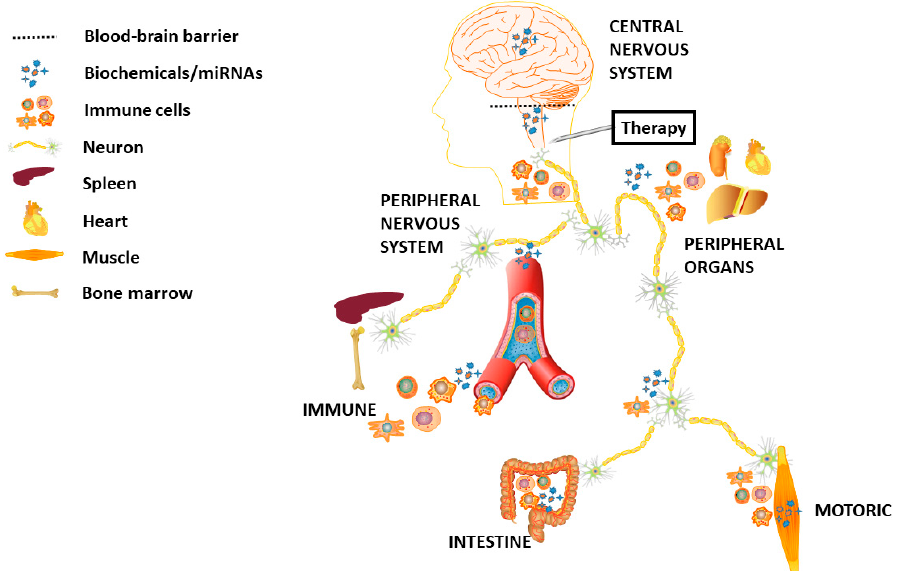
Figure 1. Conceptual visualization of therapeutic approach with an impact across a human body. In the hunt for HD biomarkers able to measure an outcome of treatment, one might choose from a whole spectrum of analytes ranging from CNS, through PNS, peripheral organs and blood, ending up in motoric skills of HD patients.